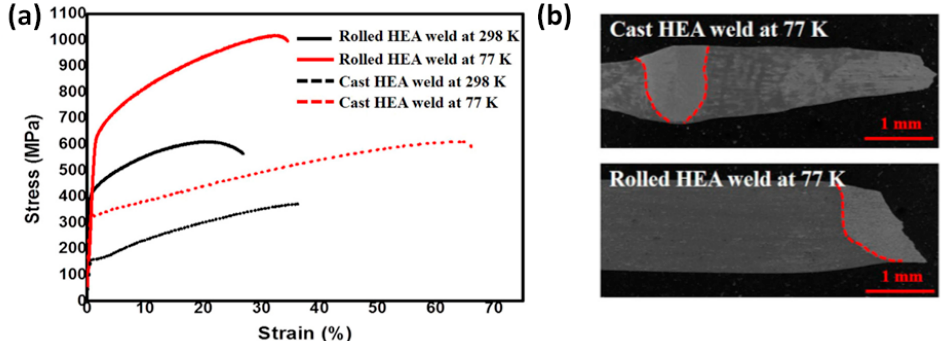
Figure 4. Tensile testing results: ( a ) Comparison between the tensile properties of the weld at different temperatures; ( b ) fracture region (Adapted from [56], with permission from Elsevier, 2019).